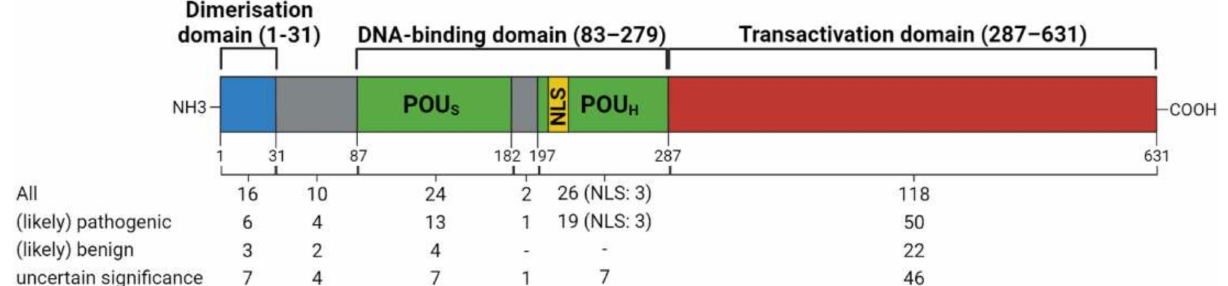
Figure 4. Schematic representation of the HNF1A (isoform A) structure with highlighted functional elements: dimerisation (blue), DNA-binding (green and yellow) and transactivation (red) domains together with the respective amino acids region shown in brackets. The mutations depicted in the figure show 196 of the 198 HNF1A-MODY-related mutations found in ClinVar database and located in the coding sequence of the gene. Two mutations from the database were not included, as they are located in the HNF1A promoter region (Supplementary Table S1). The mutations are additionally stratified by clinical significance and the total number of variations in the particular functional domain is presented. Grey boxes—disordered regions; NLS—nuclear localisation signal (range 197–205 amino acids); POU S —POU specific domain; POU H —POU homeodomain. Figure created with